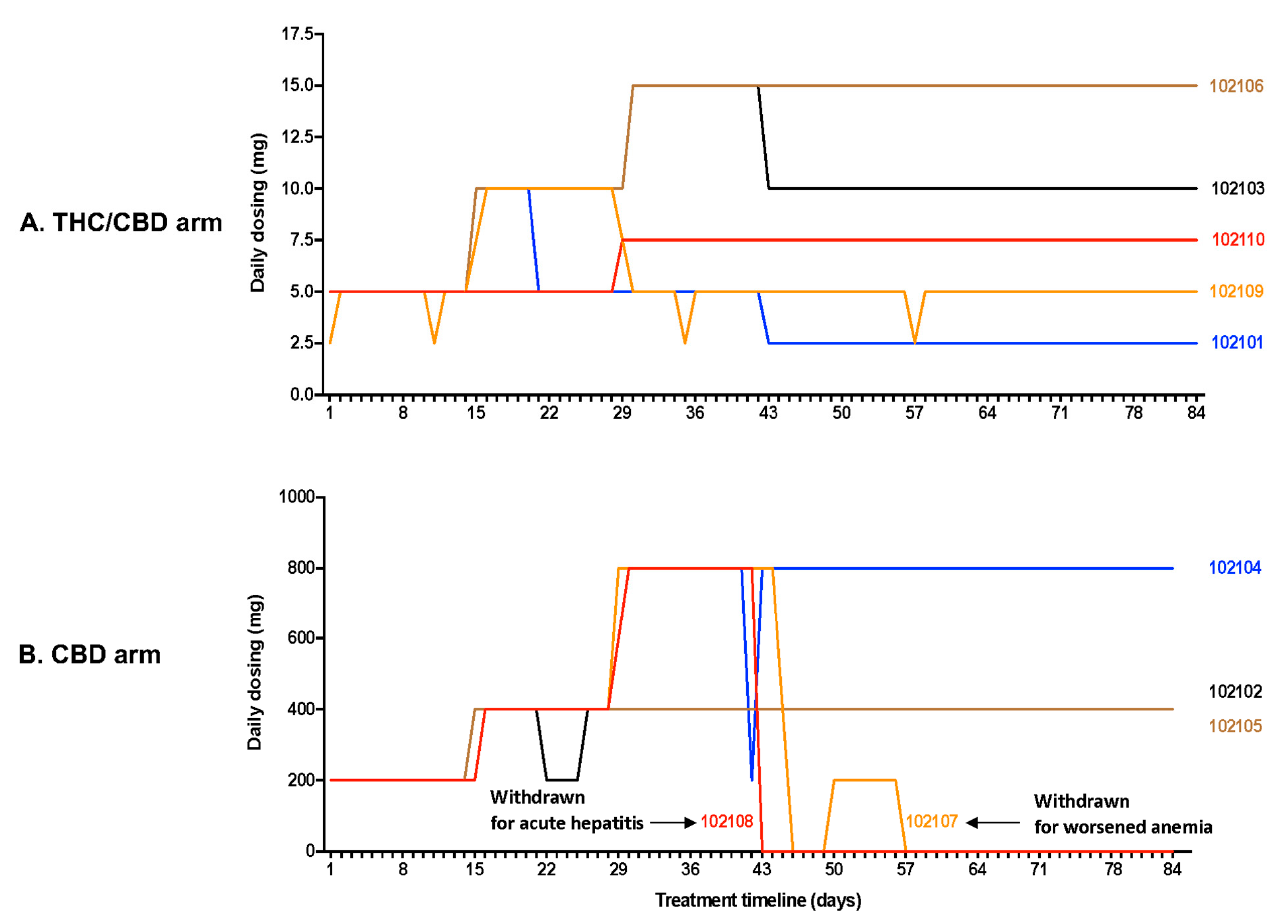
Figure 3. Daily dosage of CBD-only and THC/CBD combination during the 12 weeks of treatment. ( A ) THC/CBD arm: In arm 1 (THC/CBD), two participants were able to reach the maximum daily